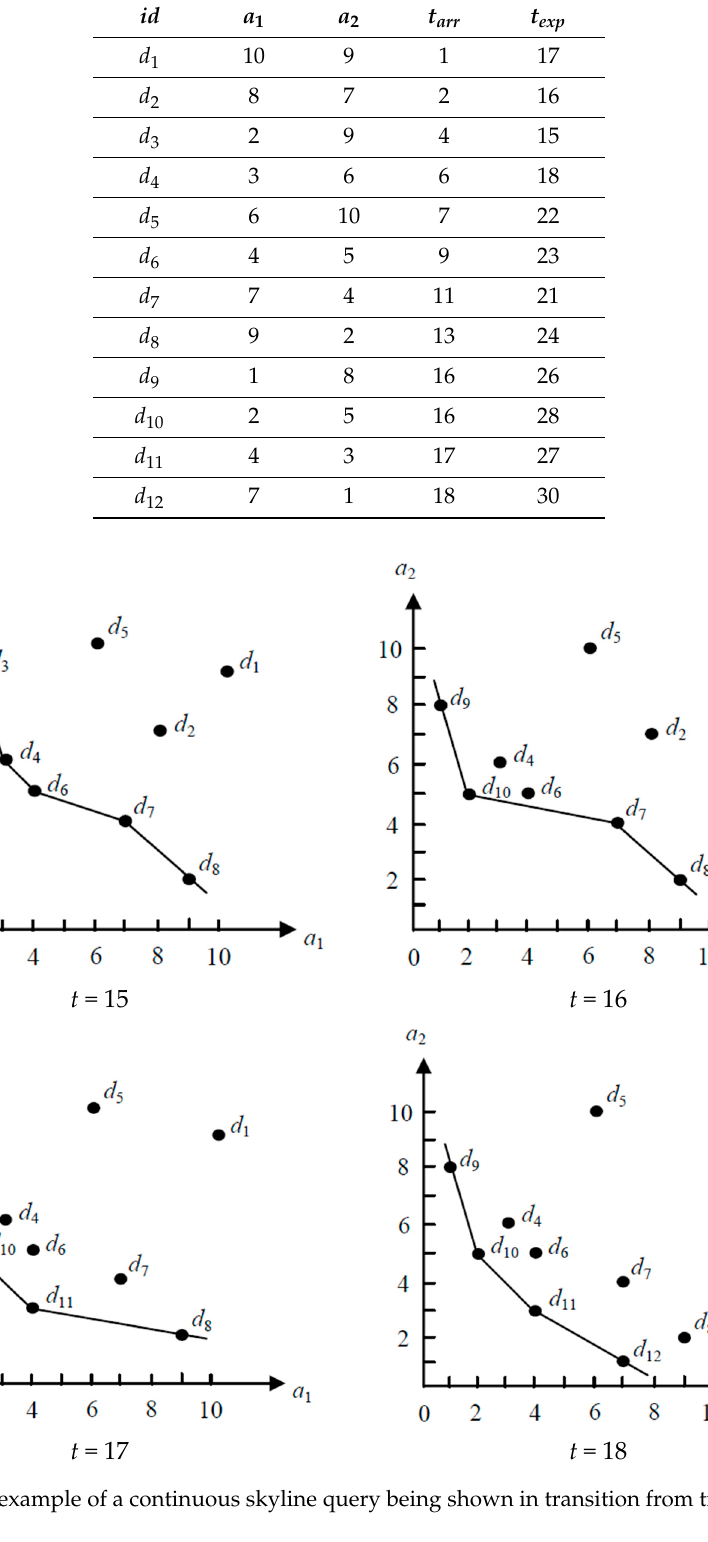
Table 1. The set of data objects with arrival and expiration times.